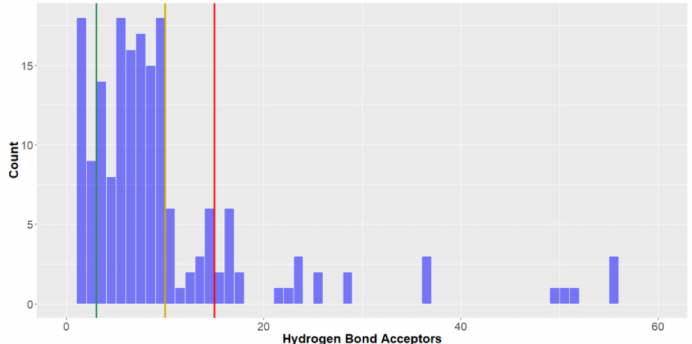
Figure 9. The statistical distribution of the hydrogen bond acceptors of all analysed compounds (green = 3, compounds < 3 are in the lead-like space; yellow = 5, compounds < 5 are in the drug-like space; red = 15, compounds < 15 are in the KDS. Total number of compounds = 179.